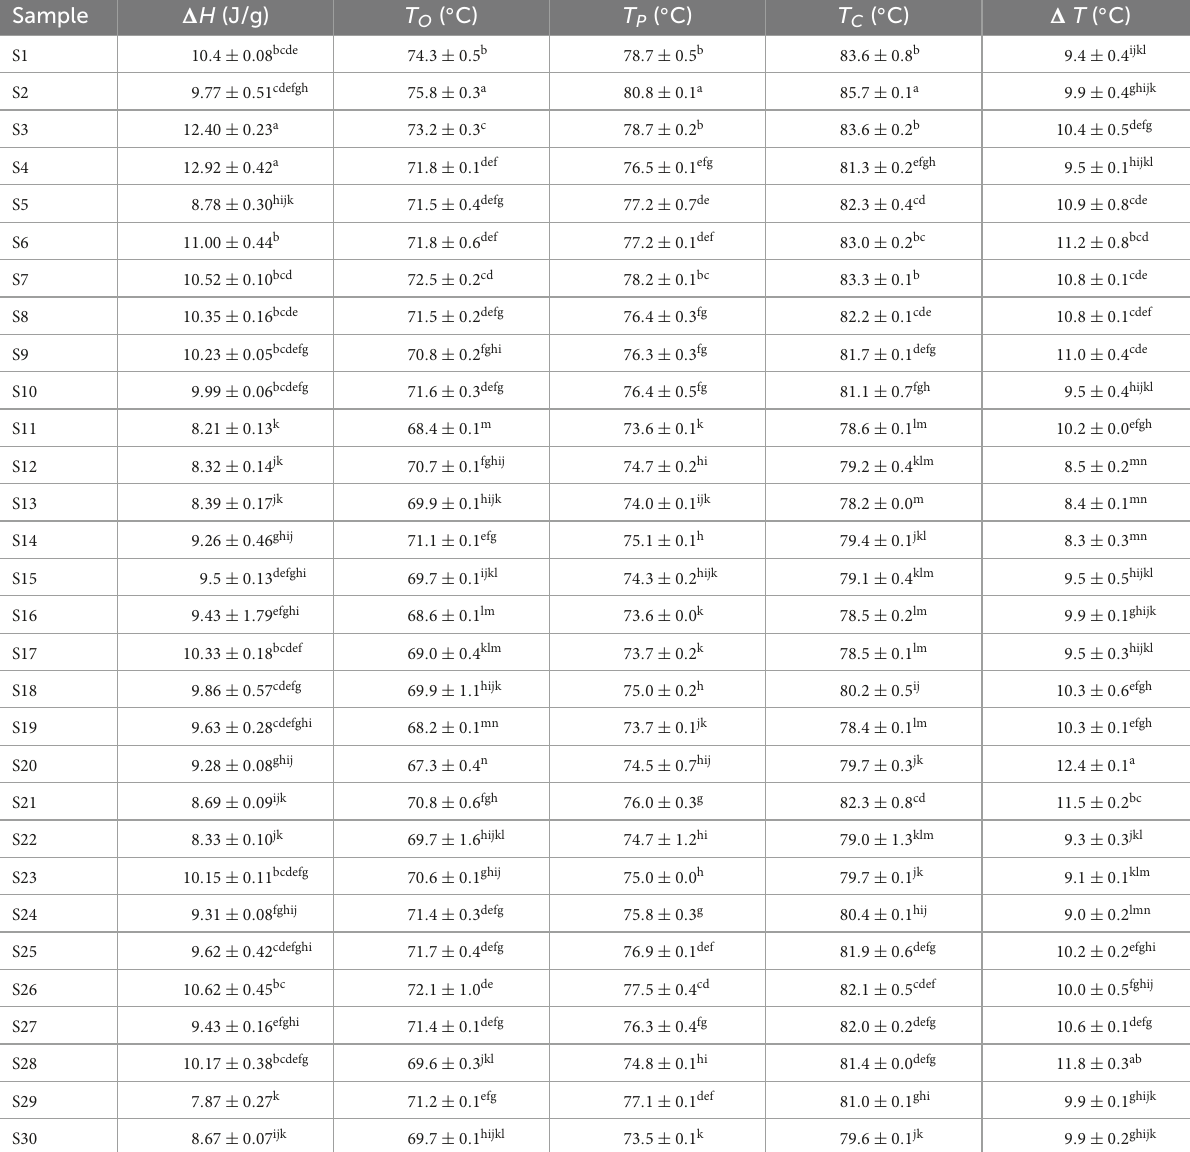
TABLE 4 Thermal properties of sorghum